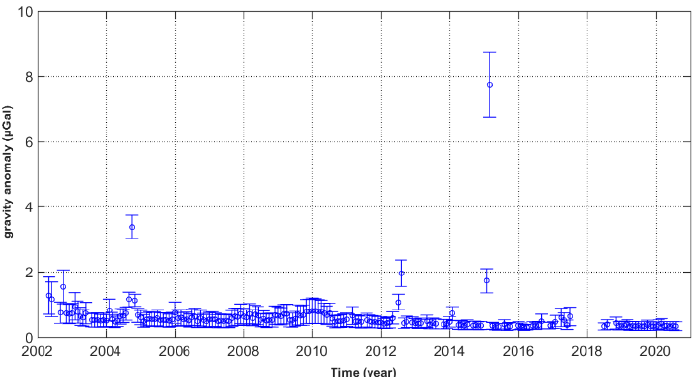
Figure 1. Global mean and standard deviation of monthly time-variable gravity field model errors. Figure 2 shows the average global error distribution of GRACE monthly models. The errors are distributed symmetrically in the north and south, are greater in low-latitude ar- eas and decrease with increasing latitude. The amplitude ranges from 0.33~0.98 µ Gal and 0.21~0.61 µ Gal in the GRACE and GFO results, respectively. The gray dots